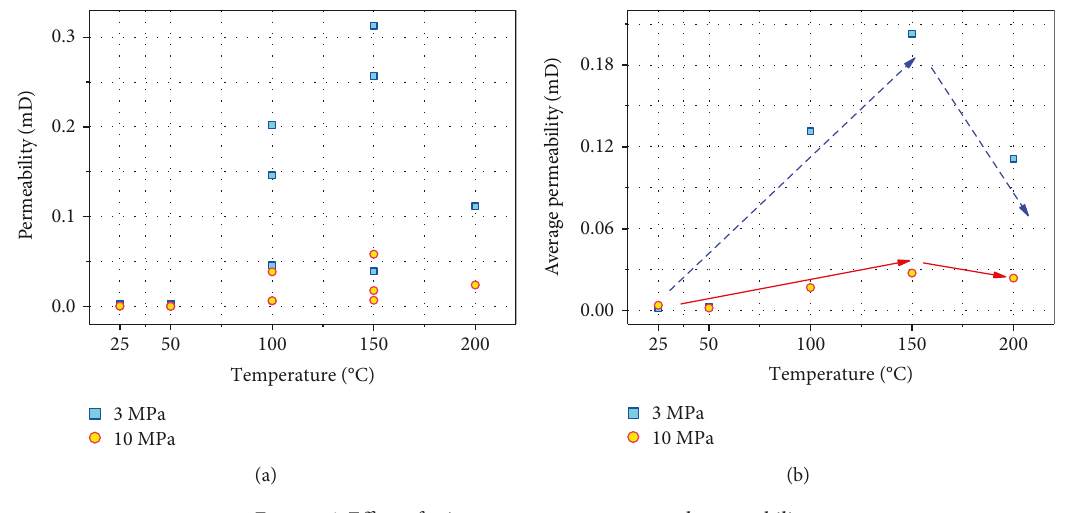
Figure 6: E ff ect of microwave treatment on coal permeability.